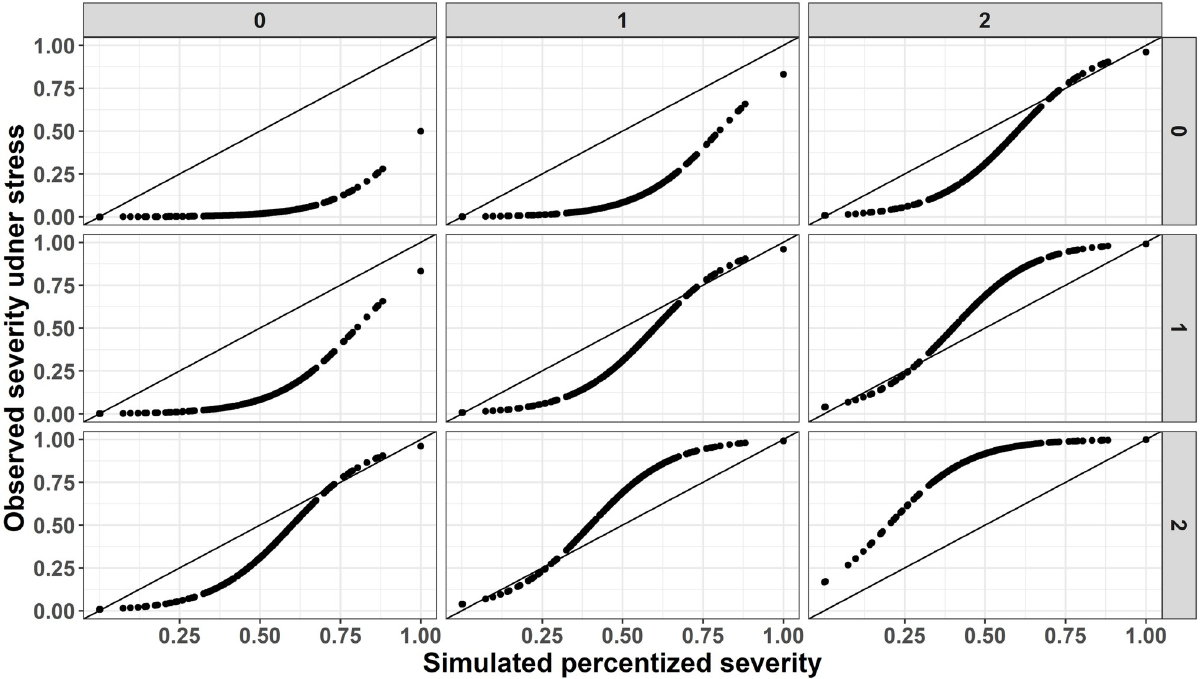
Fig 3. Simulated latent and observed severity features. Illustration of simulated severity versus the observed severity as simulated from conducting a stress test. Columns facets presents difficulty levels of domain #1 and rows facets presents the levels of difficulty domain #2. The black solid lines are identity